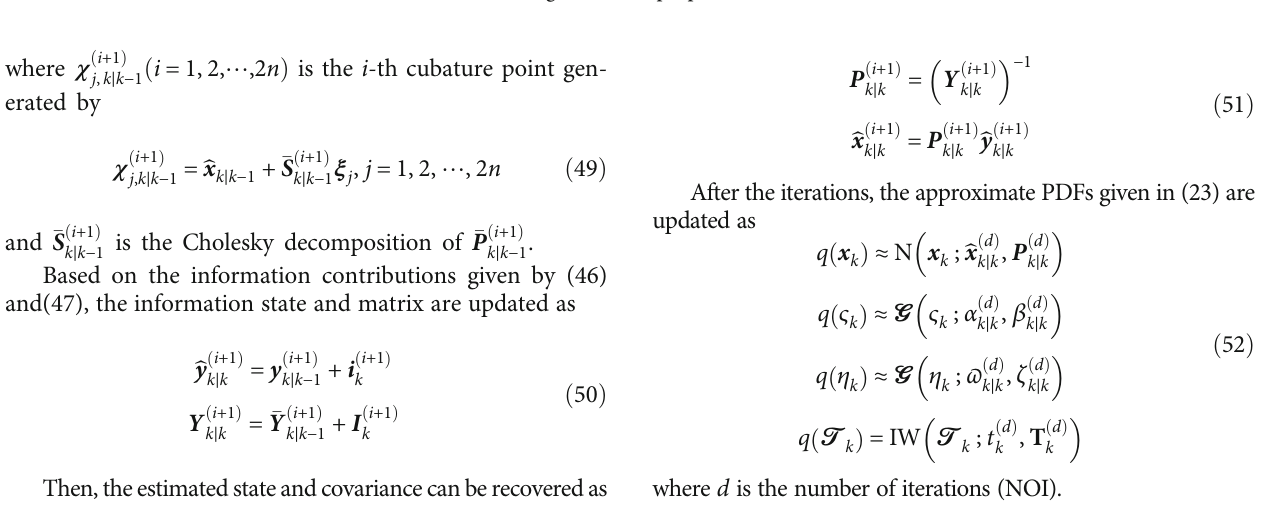
Figure 1: Diagram of the proposed